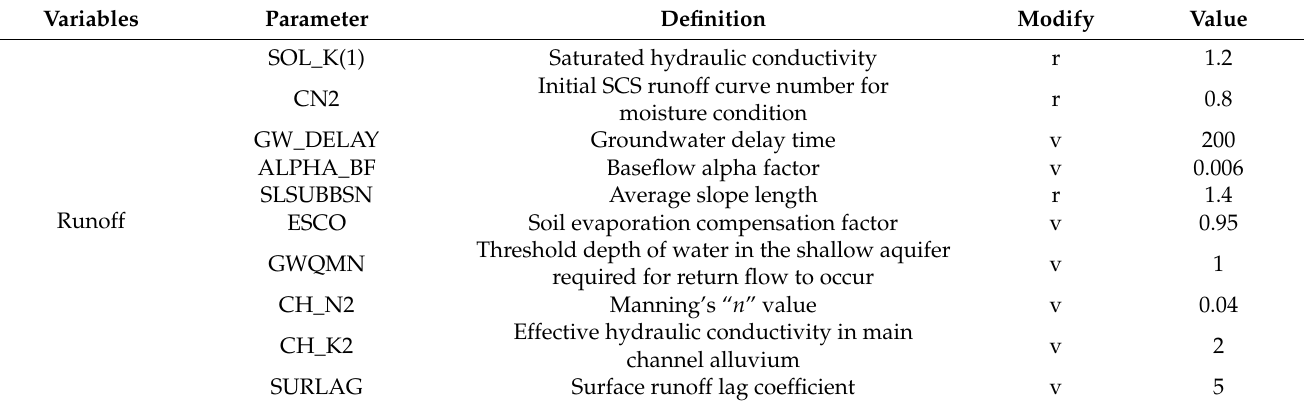
Table 6. The parameters influencing the results during